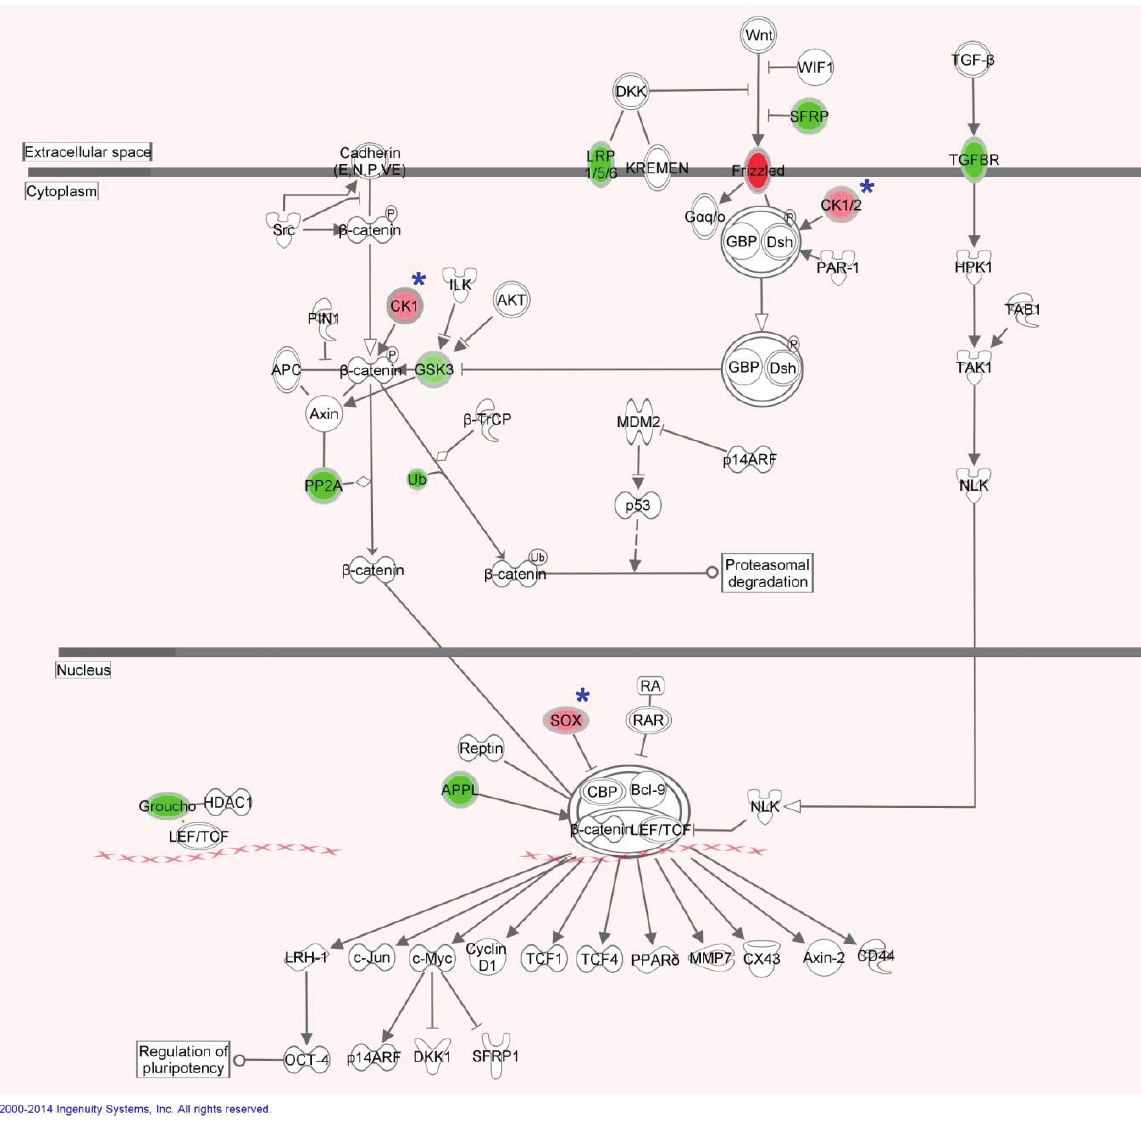
Figure 3. Canonical WNT/β -catenin signaling genes marked in green are hypermethylated in parous women (suggesting down-regulation of the gene in parous women). Genes in red are hypermethylated within nulliparous women. Genes marked with ( * ) were observed through the use of IPA (Ingenuity ® Systems)